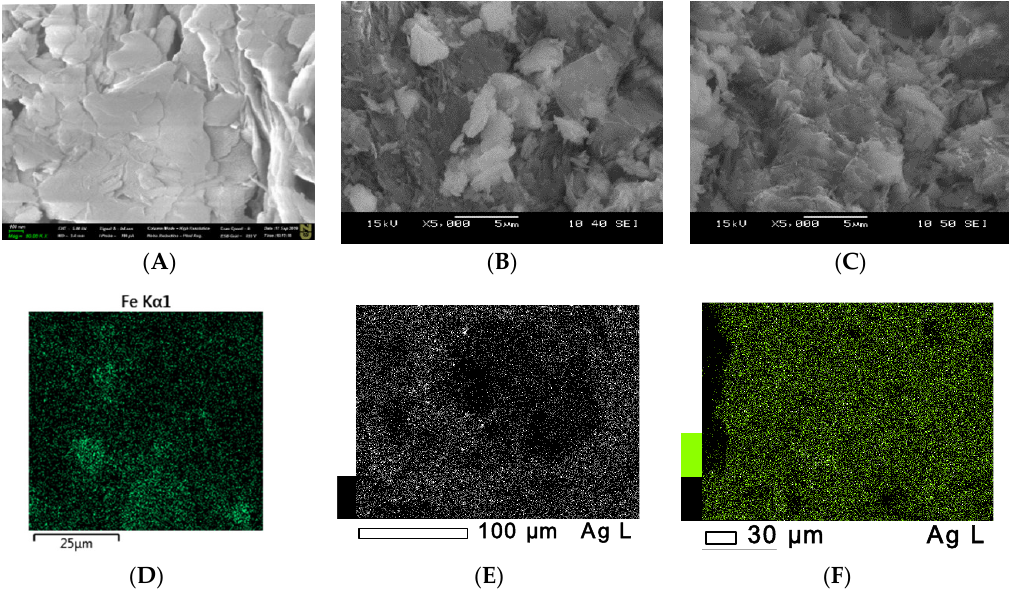
Figure 7. Scanning electron microscopy images of ( A ) Fe 3 O 4 @NZU, ( B ) Ag 2 O@NZU, ( C ) Ag 0 @NZU and energy dispersive X-ray spectroscopy of ( D ) iron on Fe 3 O 4 @NZU and silver on ( E ) Ag 2 O@NZU and ( F ) Ag 0 @NZU.